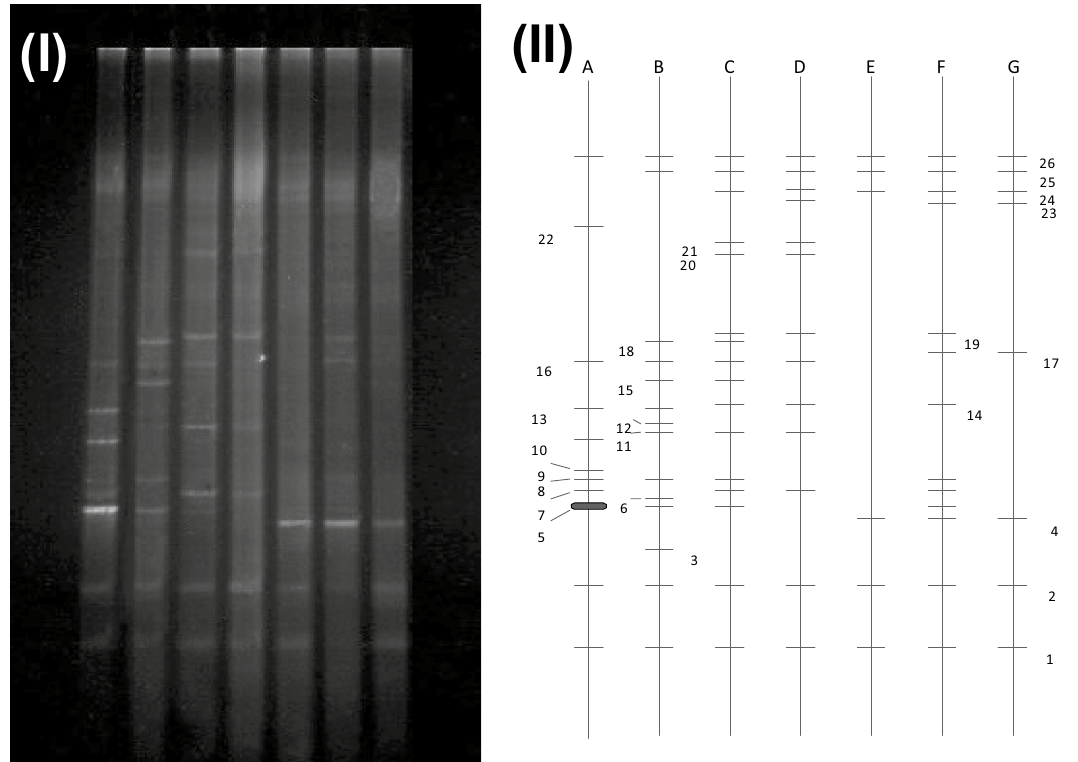
Figure 4. Comparison of microbial community of total bacteria in different samples ( A: ICBAF; B : HA tank; C : the first A tank; D : the first O tank; E : the second A tank; F : the second O tank; G : MBR) Nos. 1–26 represent the light bands; the lines at the same height in II correspond to the band in